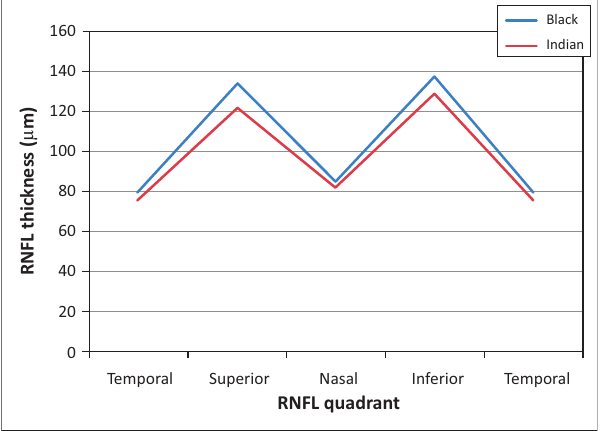
RNFL, retinal nerve fibre layer. FIGURE 1: Retinal nerve fibre layer thickness for each quadrant in the black and Indian ethnic groups.